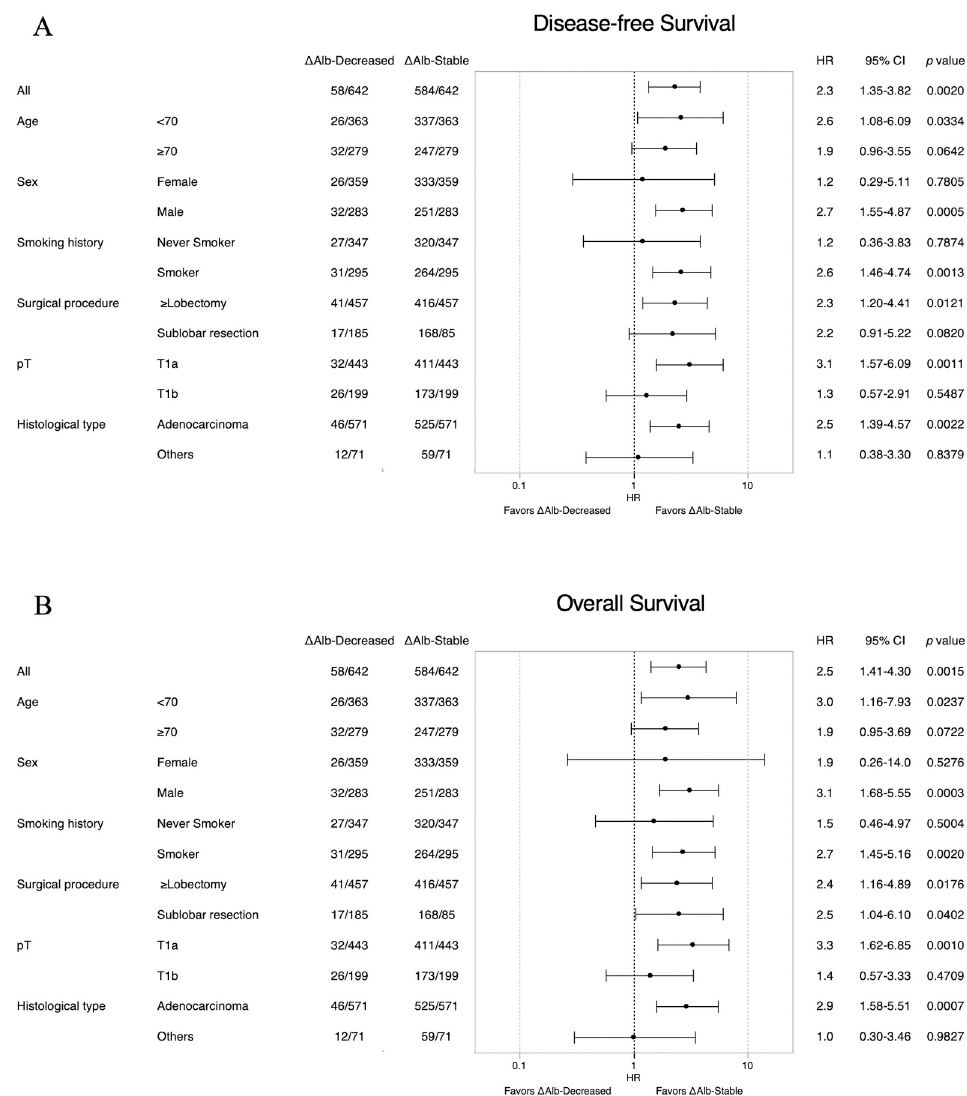
Fig 4. Forest plot of subgroup analysis for postoperative decrease in serum albumin ( Δ Alb) in the validation cohort (VC). Hazard ratios of Δ Alb for (A) disease-free survival and (B) overall survival in the VC. HR: Hazard ratio, CI: Confidence